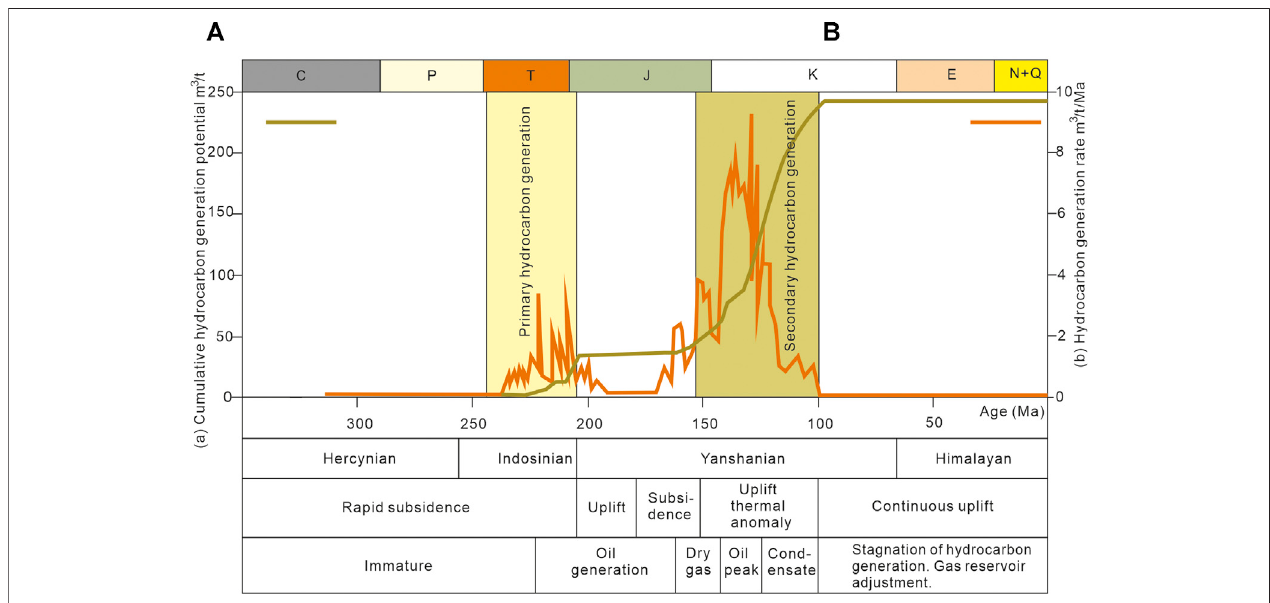
FIGURE 11 | Evolution of hydrocarbon generation potential and rate of source rocks in Qinshui Basin, modi fi ed from Hou, (2020).